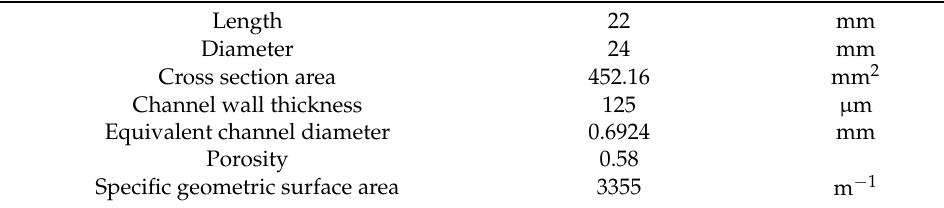
Table 1. Parameters of catalyst